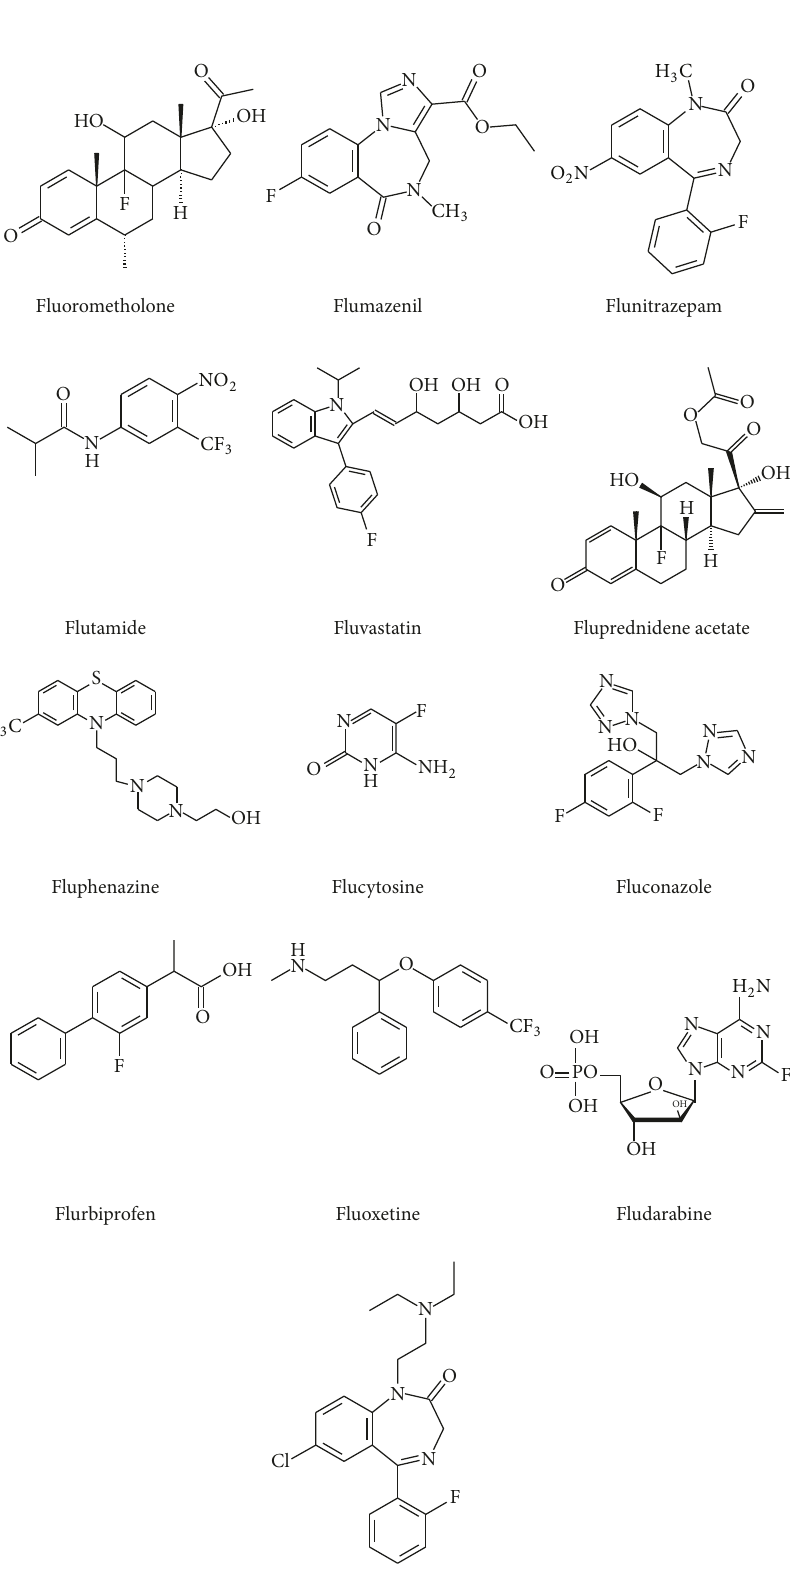
Figure 1: Chemical structures of the fluorine-containing pharmaceuticals